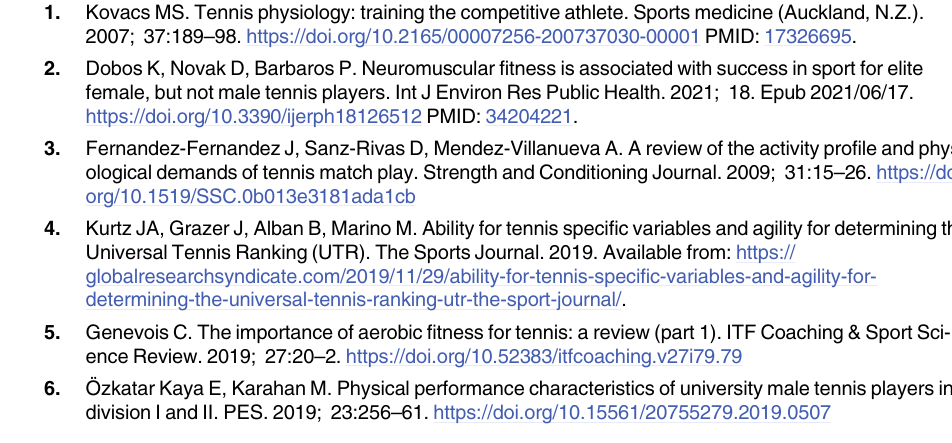
S1 Table. Quality assessment of included studies using the appraisal tool for cross-sec- tional studies (Downes et al.,